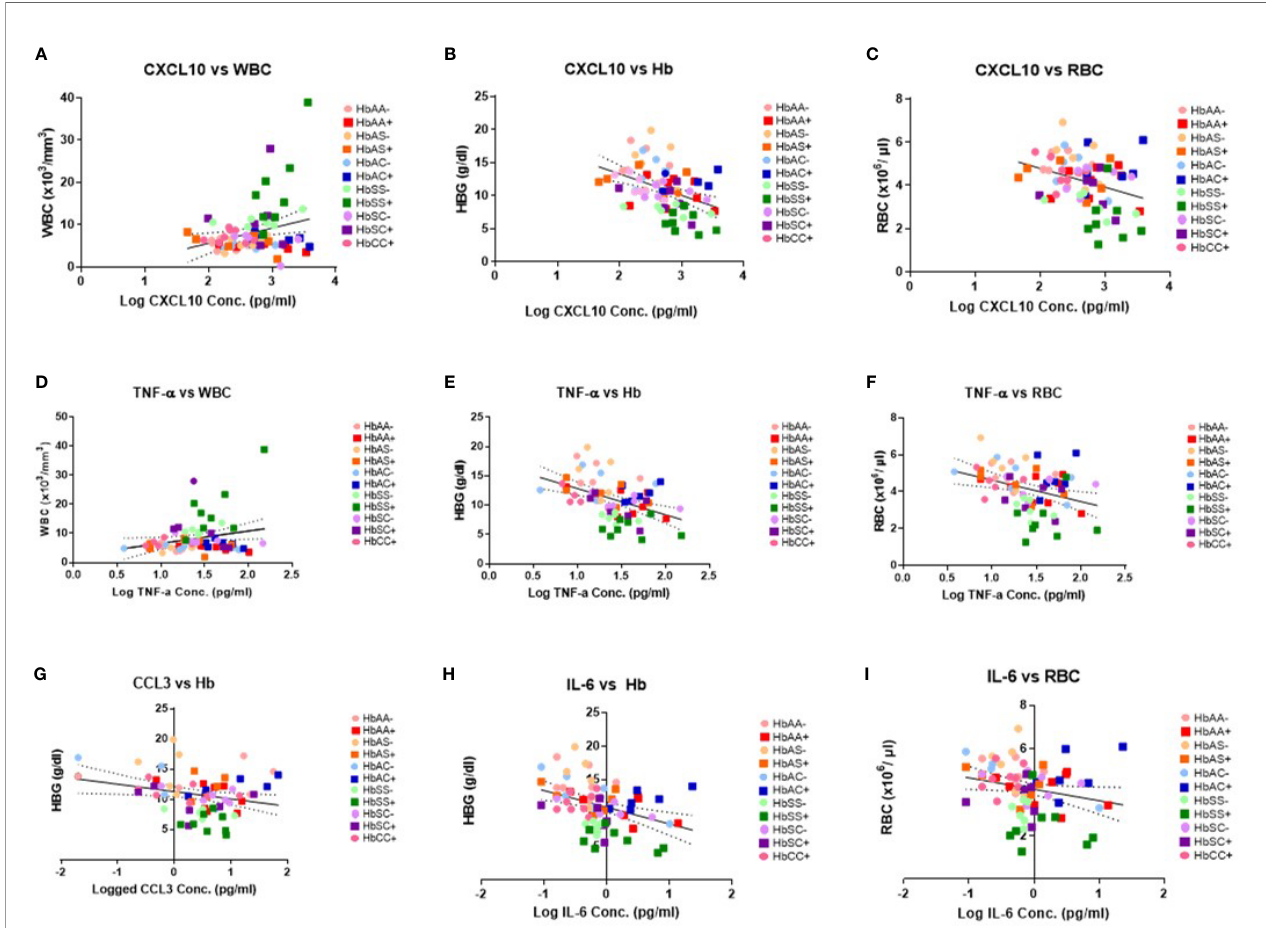
FIGURE 3 | Correlations between cytokines, WBC and RBC counts, Hb levels, and Hb genotypes with (+) and without (-) malaria. A two-tailed Pearson Correlation with a 95% con fi dence interval and a linear regression was used for all comparisons. (A) Log transformed CXCL10 concentration vs WBC counts (R 2 = 0.07, P = 0.02) and Y = 3.61X-1.55. (B) Log transformed CXCL10 concentration vs Hb levels (R 2 = 0.19, P = 0.0001) and Y = 3.244X-19.83. (C) Log transformed CXCL10 concentration vs RBC counts (R 2 = 0.11, P = 0.004) and Y = -0.868X+6.53. (D) Log transformed TNF- a concentration vs WBC counts (R 2 = 0.06, P = 0.04) and Y = 4.239X+2.36. (E) Log transformed TNF- a concentration vs Hb levels (R 2 = 0.02, P < 0.0001) and Y = -4.48+17.34. (F) Log transformed TNF- a concentration vs RBC counts (R 2 = 0.11, P = 0.004) and Y = -1.16X +5.79. (G) Log transformed CCL2 concentration vs Hb levels (R 2 = 0.07, P = 0.03) and Y = -1.22X+11.28. (H) Log transformed IL-6 concentration vs Hb levels (R 2 = 0.15, P = 0.0007) and Y = -2.49X+10.88. (I) Log transformed IL-6 concentration vs RBC counts (R 2 = 0.05, P = 0.047) and Y =